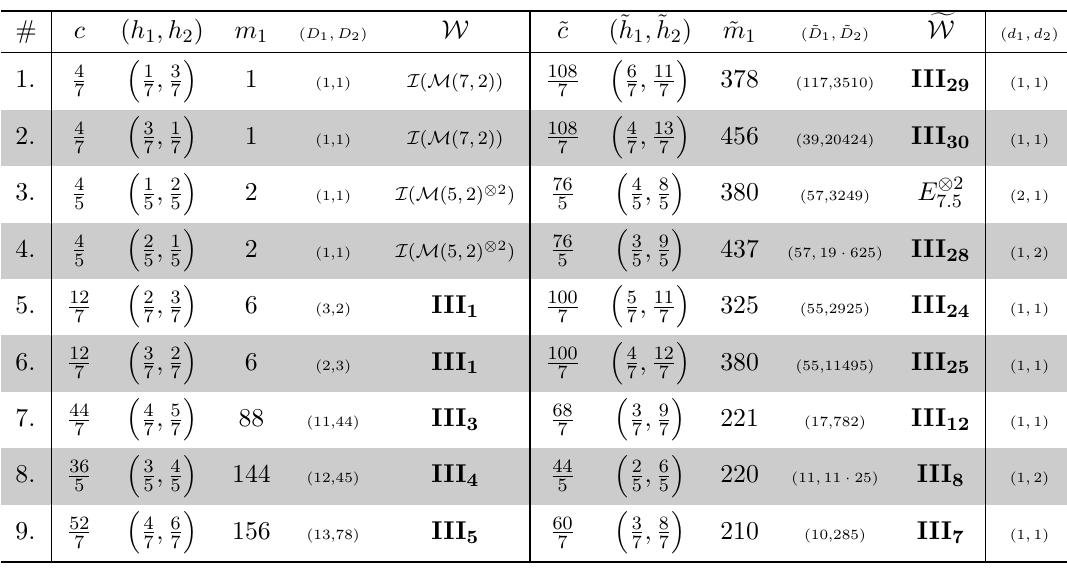
Table 6. IVOA-type pairings, c H = 16 with ( n 1 , n 2 ) = (1 , 2) . The two sets of characters pair up to j 2 3